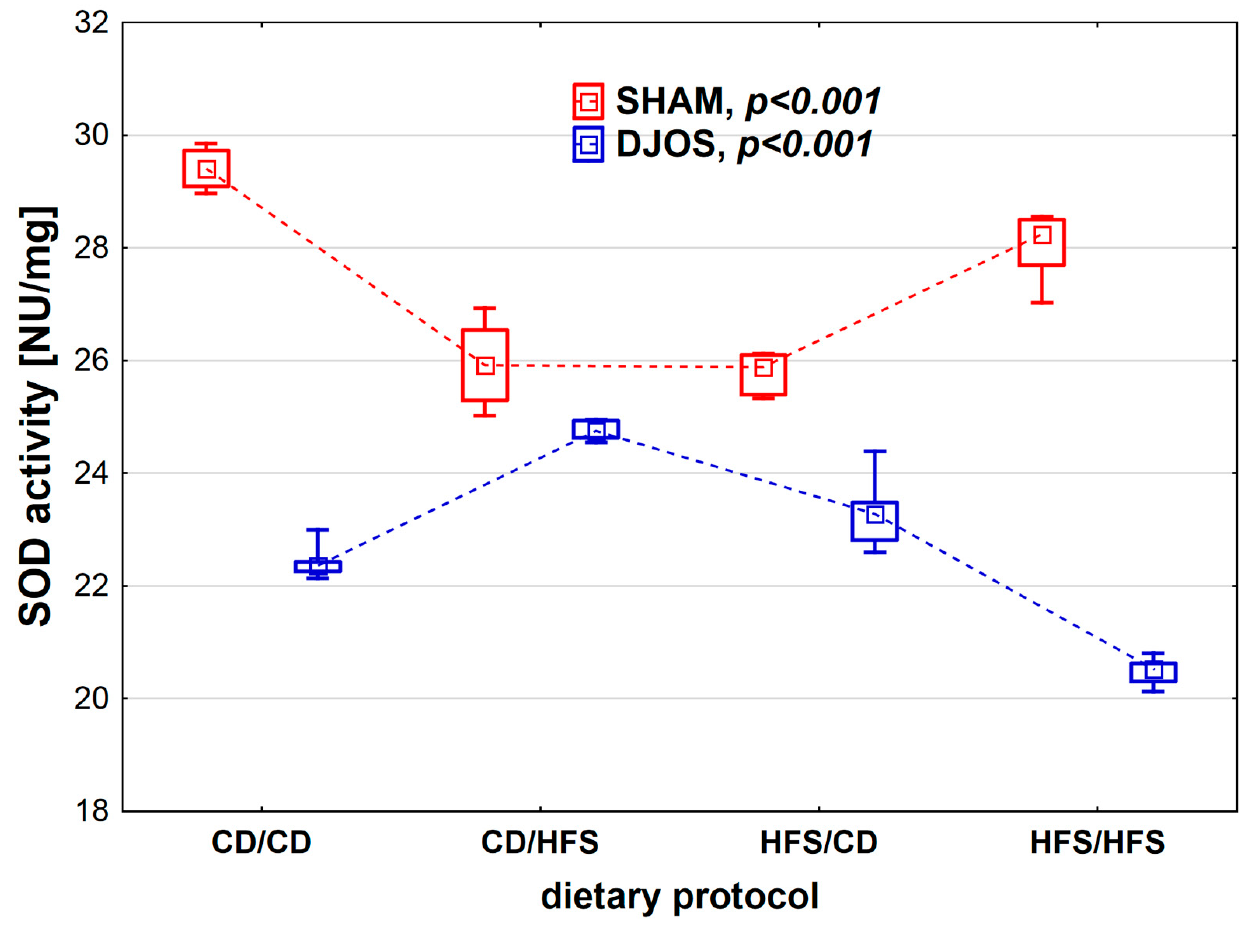
Figure 2. Superoxide dismutase (SOD) activity (NU/mg) in the plasma of Sprague-Dawley rats subjected to duodenojejunal omega switch (DJOS) and control (SHAM) surgery and different dietary protocols at 8 weeks after the surgery. Legend: CD—control diet, HFS—high fat/high sugar diet, NU—nitrate unit. The inner boxes represent the medians, the outer boxes represent interquartile ranges, and whiskers represent min–max range. For the reader’s convenience, the medians are connected with dashed lines.